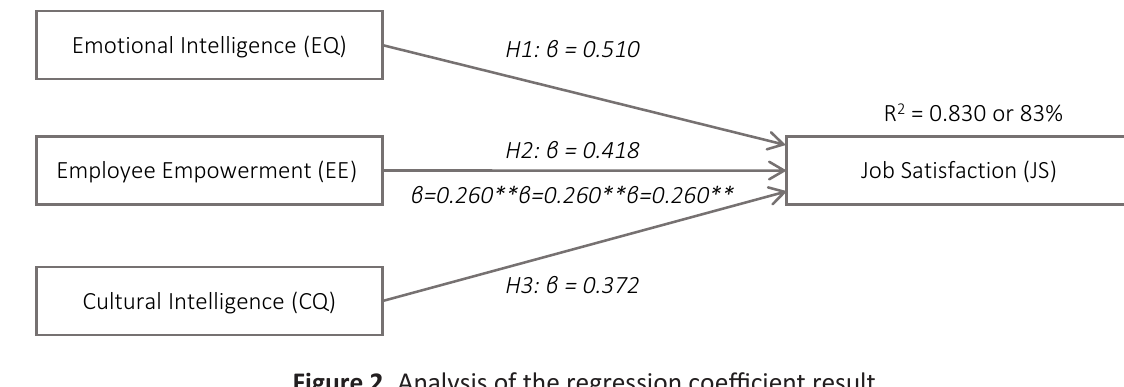
Figure 2. Analysis of the regression coefficient